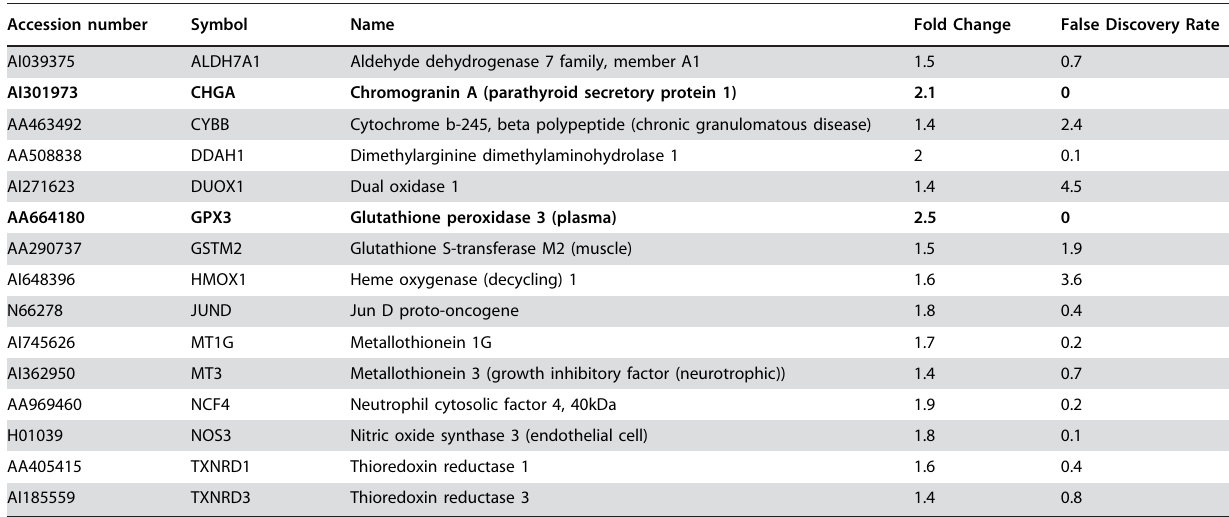
Table 4. Genes involved in oxidative stress that are upregulated in NPC fibroblasts. .. ... .... ... ... .... ... ... .... ... ... .... ... ... .... ... ... .... ... ... .... ... ... .... ... ... .... ... ... .... ... ... .... ... ... .... ... ... .... ... ... .... ... ...